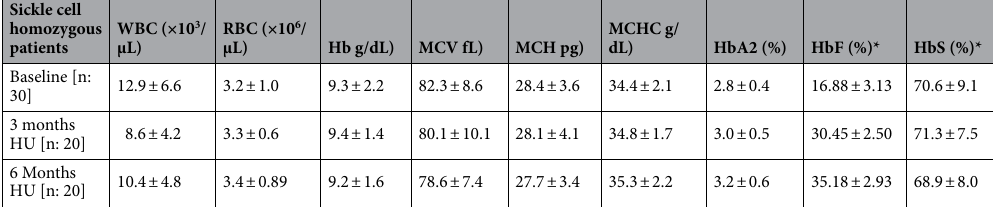
Table 1. The haematological parameters of HbS homozygous patients at baseline and after HU treatment. n: Number of samples analysed. *: p < 0.00001, before and after HU therapy.